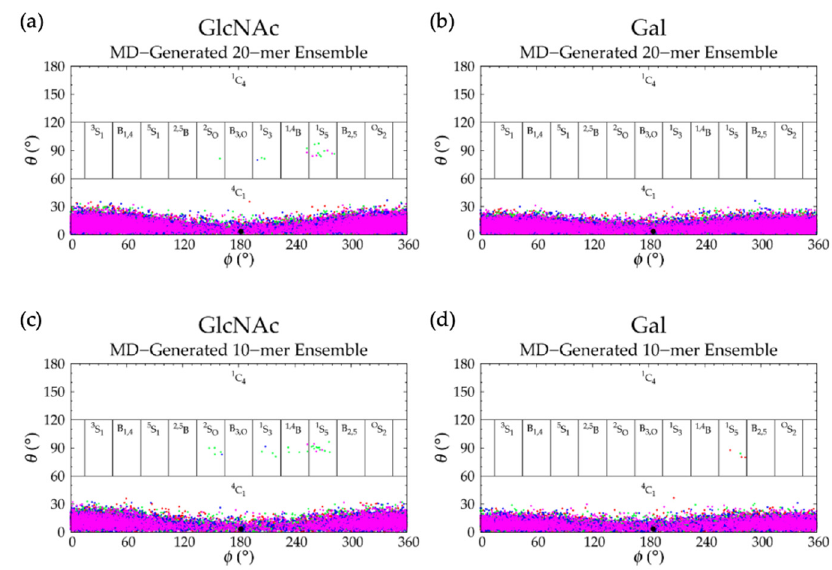
Figure 15. Cremer–Pople data for MD-generated nonsulfated keratan ensembles: ( a ) GlcNAc and ( b ) Gal in the 20-mer and ( c ) GlcNAc and ( d ) Gal in the 10-mer; geometries from the four sets of each ensemble are represented by red, green, blue, and magenta dots, respectively and the force-field geometry is represented by a single large black dot; Cremer–Pople parameters ( φ , θ ) for all rings in every tenth snapshot from each ensemble were plotted (i.e., 10 rings × 1000 snapshots per run × 4 runs = 40,000 parameter sets for the 20-mer and 20,000 parameter sets for the 10-mer). Glycosidic linkage free energy ∆ G ( φ , ψ ) analysis of Gal β 1-4GlcNAc linkages revealed a global minimum in the basin with − φ , + ψ and a secondary minimum in the basin with − φ , − ψ (Figure 16a